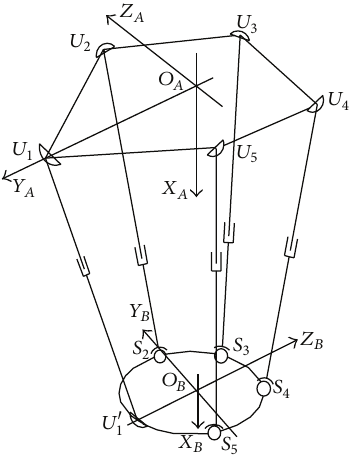
Figure 1: Mechanism diagram of 4-UPS-UPU.